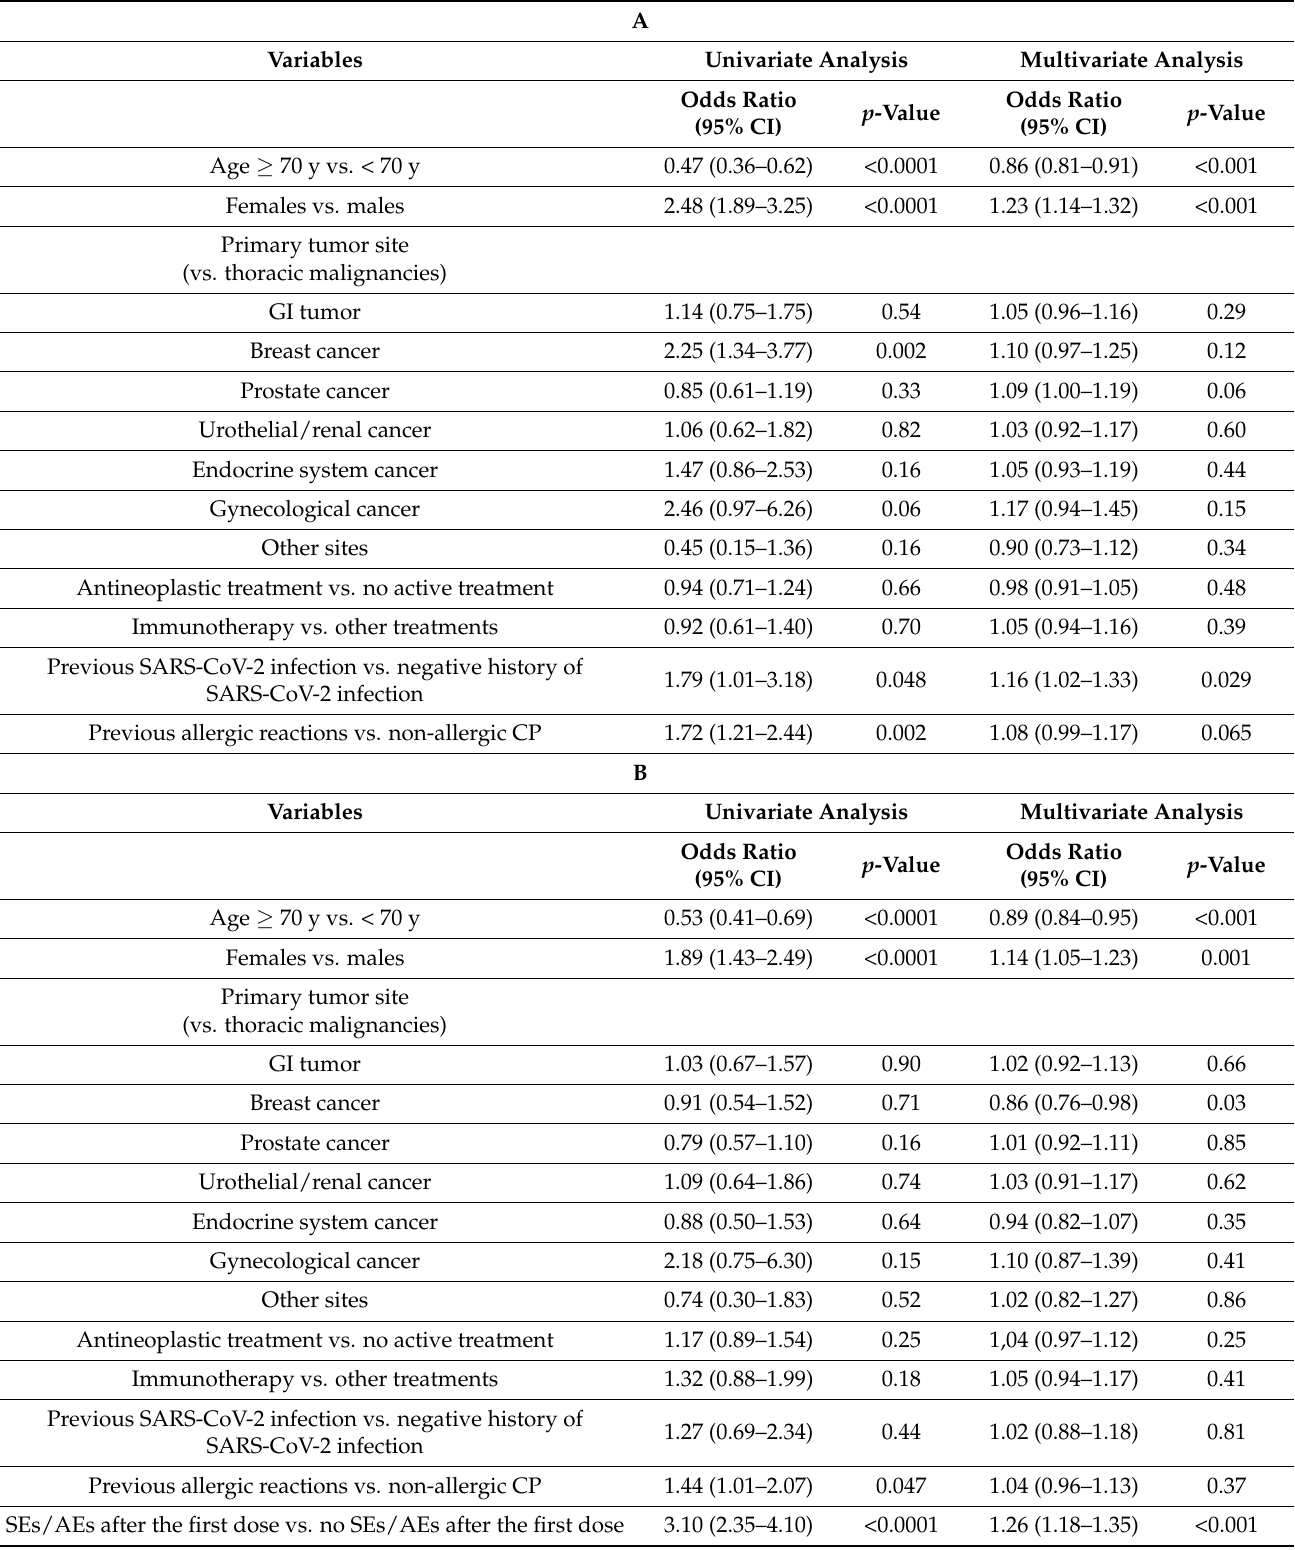
Table 3. Univariate and multivariate analyses and odds of SEs/AEs after the first dose (A) and after the second dose (B) based on all selected variables. GI: gastrointestinal; CP: cancer patients; SEs: side effects; AEs: adverse